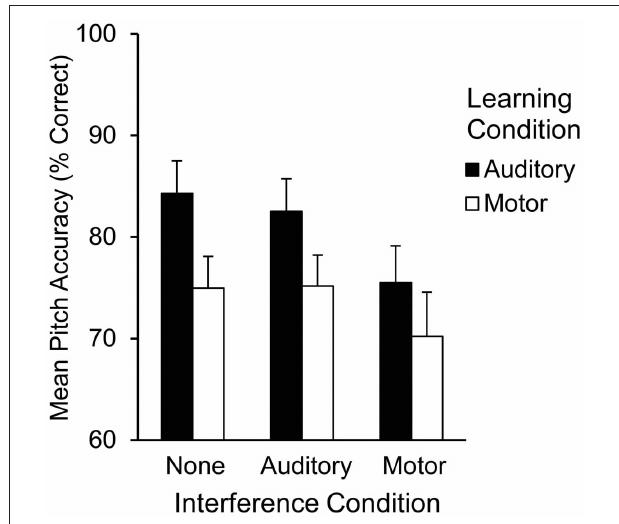
FIGURE 3 | Mean pitch accuracy (% correct pitches) during Recall by learning condition and interference condition in Experiment 2.